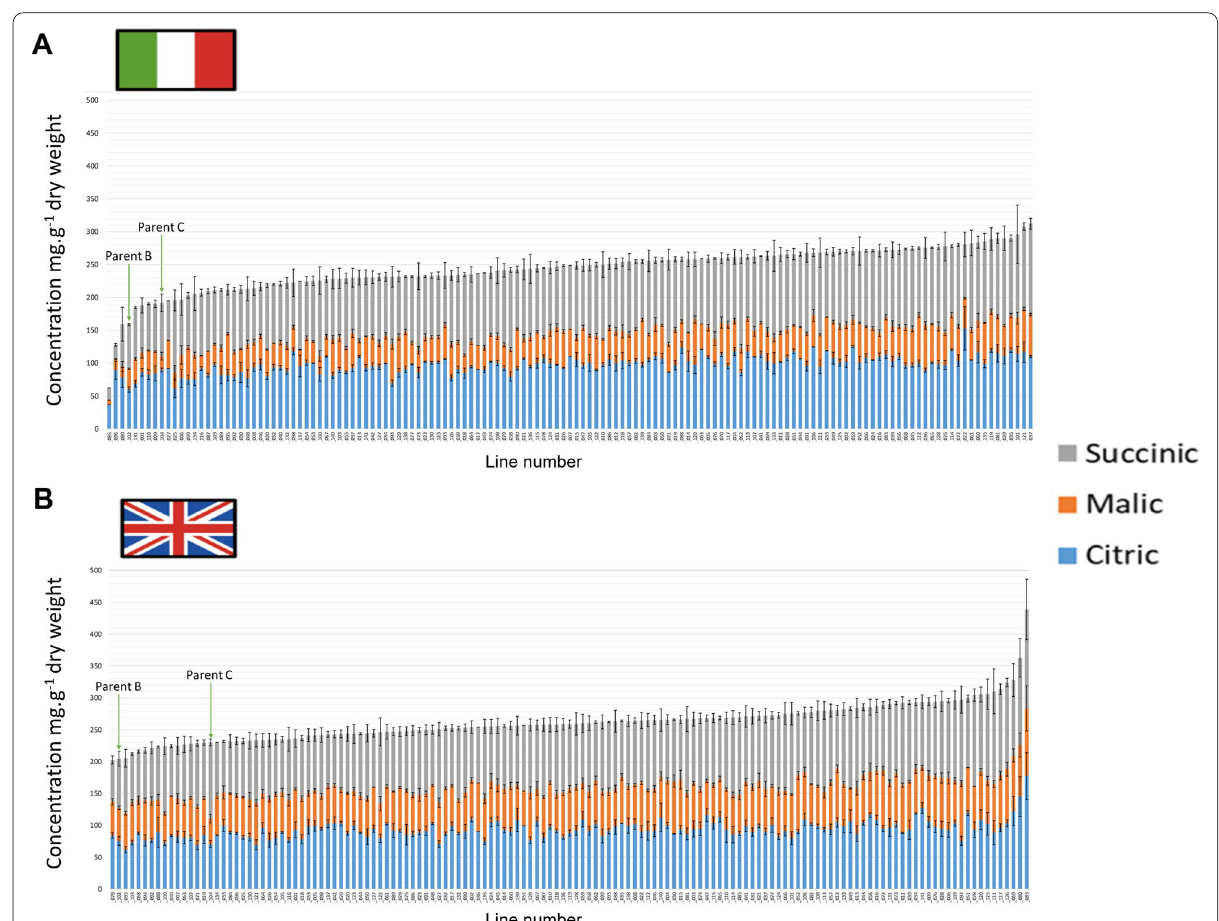
Fig. 4 Organic acid compositions and concentrations (mg g − 1 dry weight) of 139 F 4 Eruca vesicaria subsp. sativa mapping population lines and their parental lines B and C cultivated in Italy ( A ) and the United Kingdom ( B ). Lines are ordered along the x-axis according to total organic acid